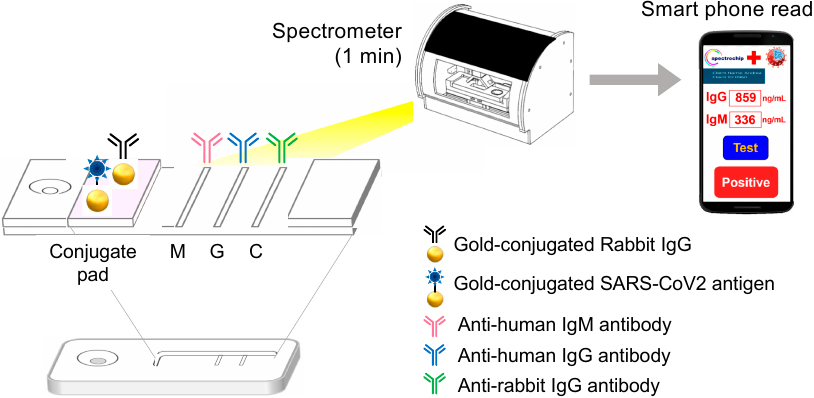
Figure 3. The workflow of this new spectrum analyzer platform system involves applying 1 mL of whole blood, blood serum, or plasma from a fingertip or from a vein to the test strip and provides results in 10–15 min depending on the reagent used. The test strip is placed in a spectrometer for quantitative spectral analysis. This scan takes approximately one minute to complete. Automatic scanning of the rapid test strip is activated with an app. Full-spectrum antibody reflex optical signals are acquired from the spectral optical module to analyze the COVID-19 IgG/IgM full-spectrum antibody distribution and concentration with standard quantification. The results can be used in conjunction with clinical timetables to analyze and track the spread of COVID-19.